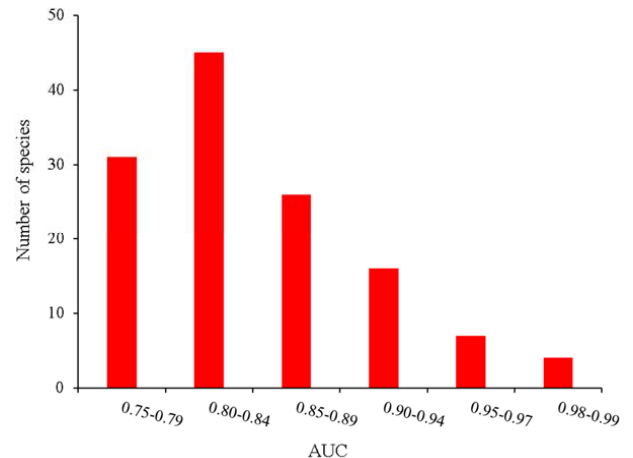
Fig. 2: Frequency of AUC scores in ROC tests among species of birds in this study